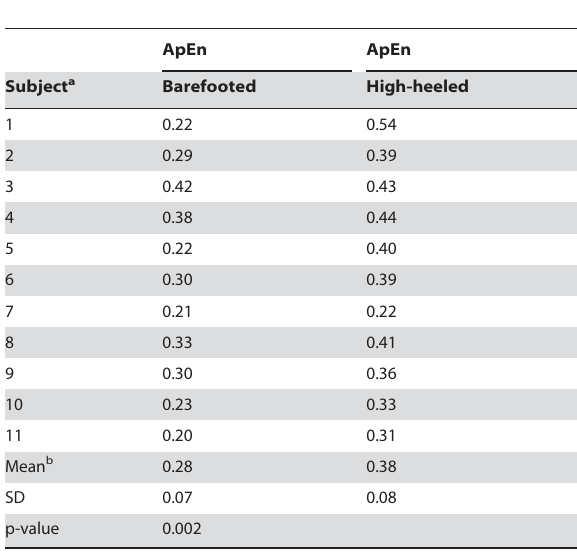
Table 2. Approximate entropy (ApEn) of the joint ankle angle.